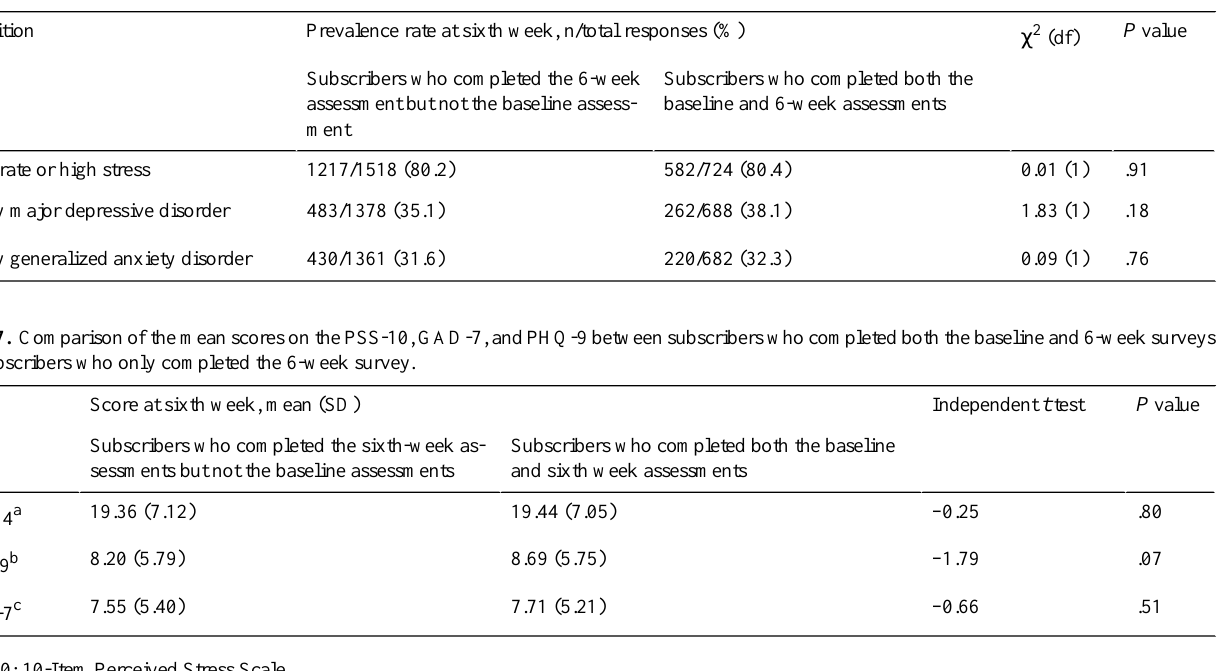
Table 6. Comparison of the prevalence rates of moderate or high stress, likely generalized anxiety disorder, and likely major depressive disorder between subscribers who completed both the baseline and 6-week surveys and subscribers who only completed the 6-week survey.